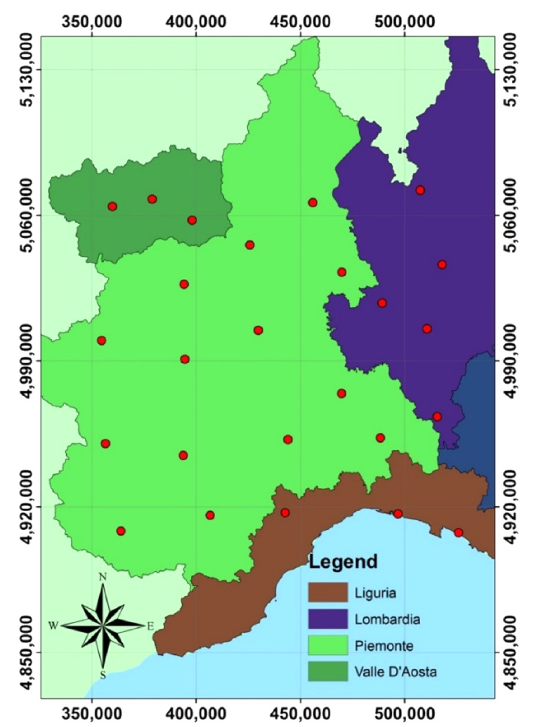
Figure 1. The study area and the 25 GNSS Permanent Stations referred to UTM-WGS84 (ETRF2000) (Universal Transverse Mercator) (horizontal coordinates are in meters)